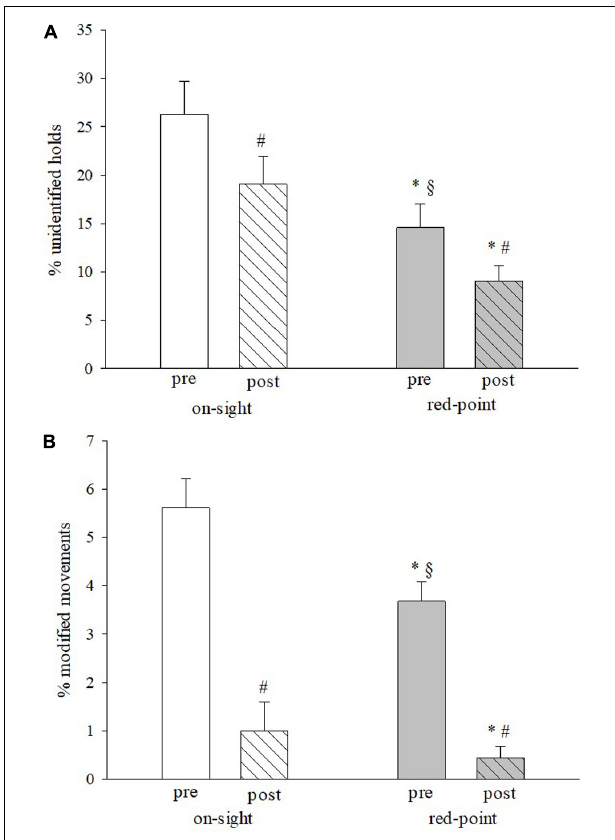
FIGURE 3 | Percentage of incorrectly identified holds on the route (A) in the two test conditions and the percentage of the holds used differently during the climb from that stated on the RI test (B) . Mean ± SE ∗ P < 0.05 vs. on-sight; # P < 0.05 vs. pre; § P < 0.05 vs. post